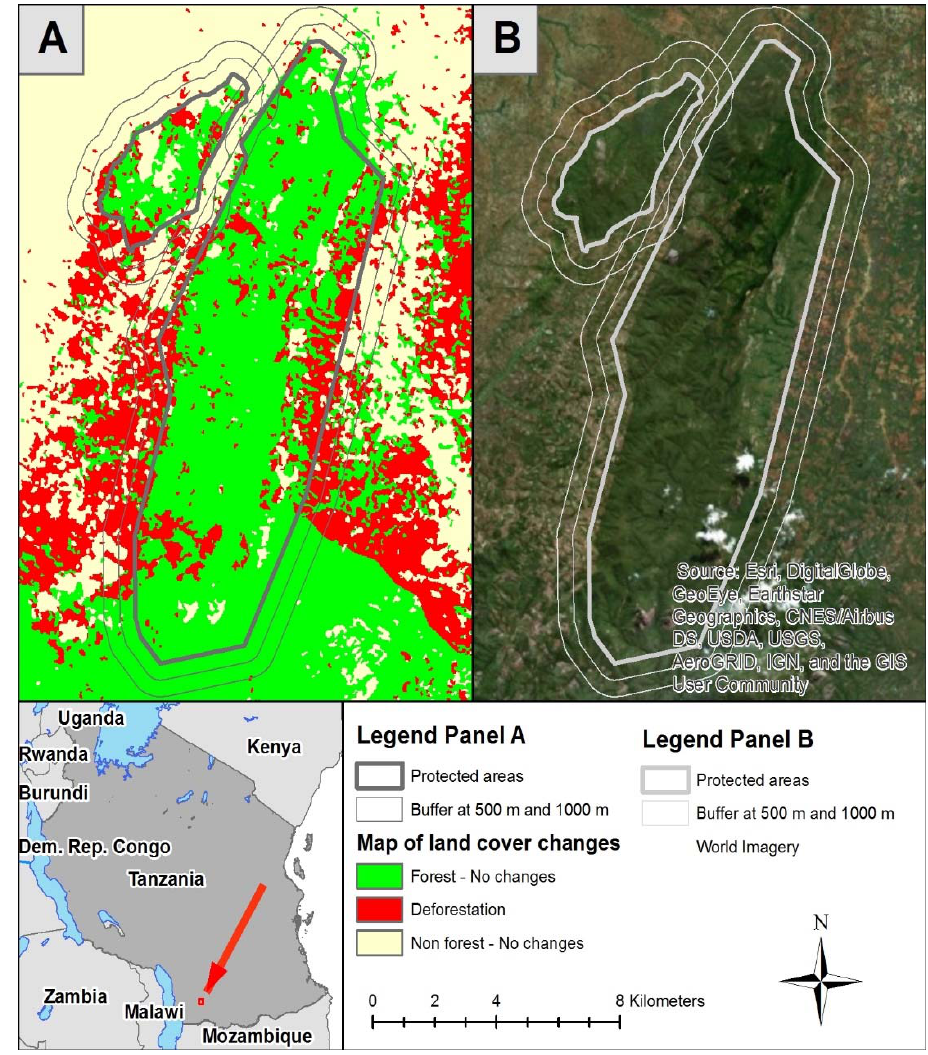
Figure 5. Deforestation in the buffer areas of two isolated PAs (Forest Reserves of Matogoro West and Matogoro East), Southern Tanzania. Panel A is of this study; and Panel B is image from space imagery providers.